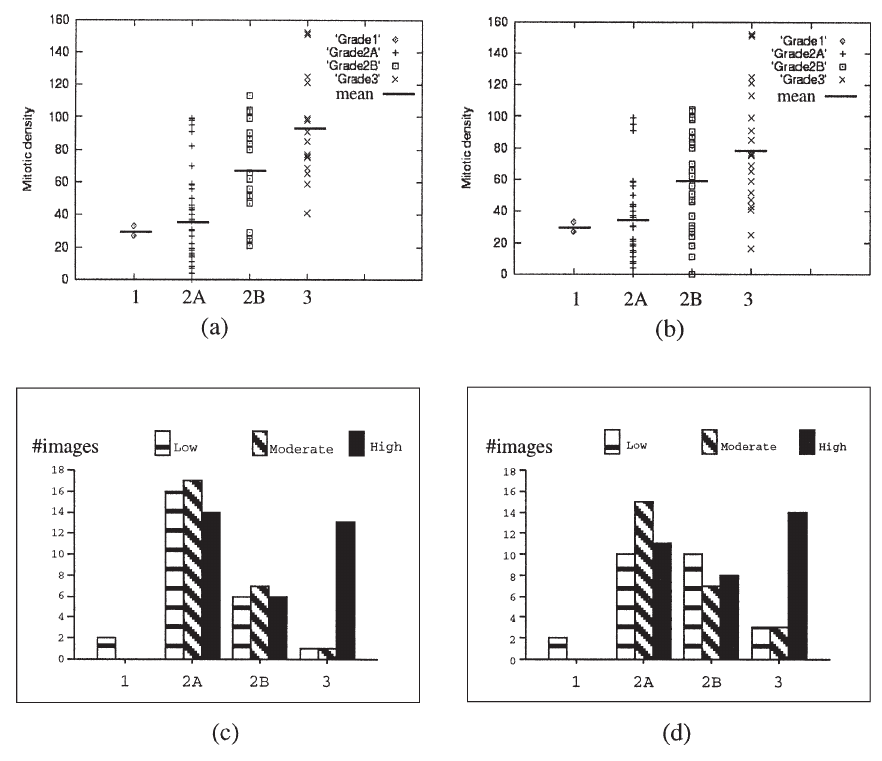
Fig. 9. Four groups: (a) Mitotic density related to subjective grading. Difference of mean is significant ( p < 0 . 01) between Grade 2A and Grade 2B, Grade 2A and 3. (b) Mitotic density related to computer grading. Difference of mean is significant ( p < 0 . 01) between Grade 2A and Grade 3. (c) p53 expression classes (low, moderate, high) related to subjective grading. (d) p53 expression classes (low, moderate, high) related to computer